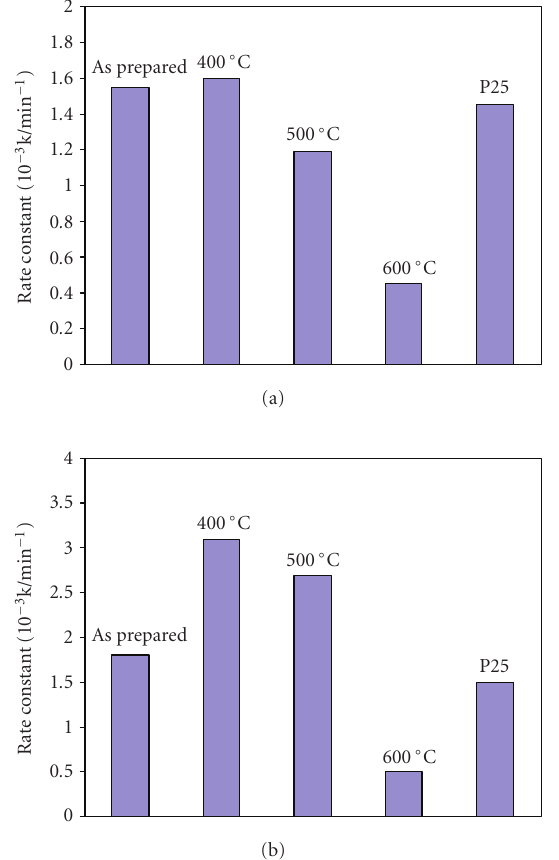
Figure 8: Photocatalytic activity of fluorinated TF10 (a) and TF20 (b) titania powders evaluated by decomposition of